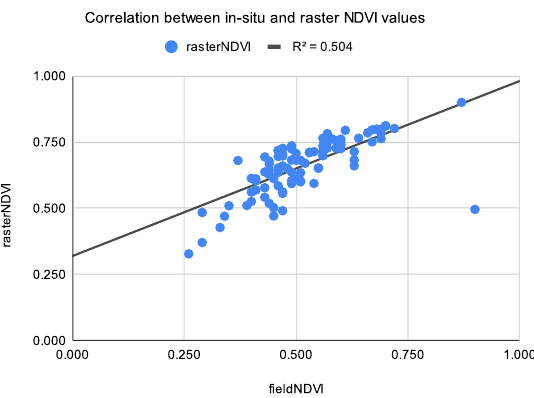
Figure 7. Correlation between the average NDVI values for the sample NDVI points and raster NDVI values from Sequoia, 29 May 2020.